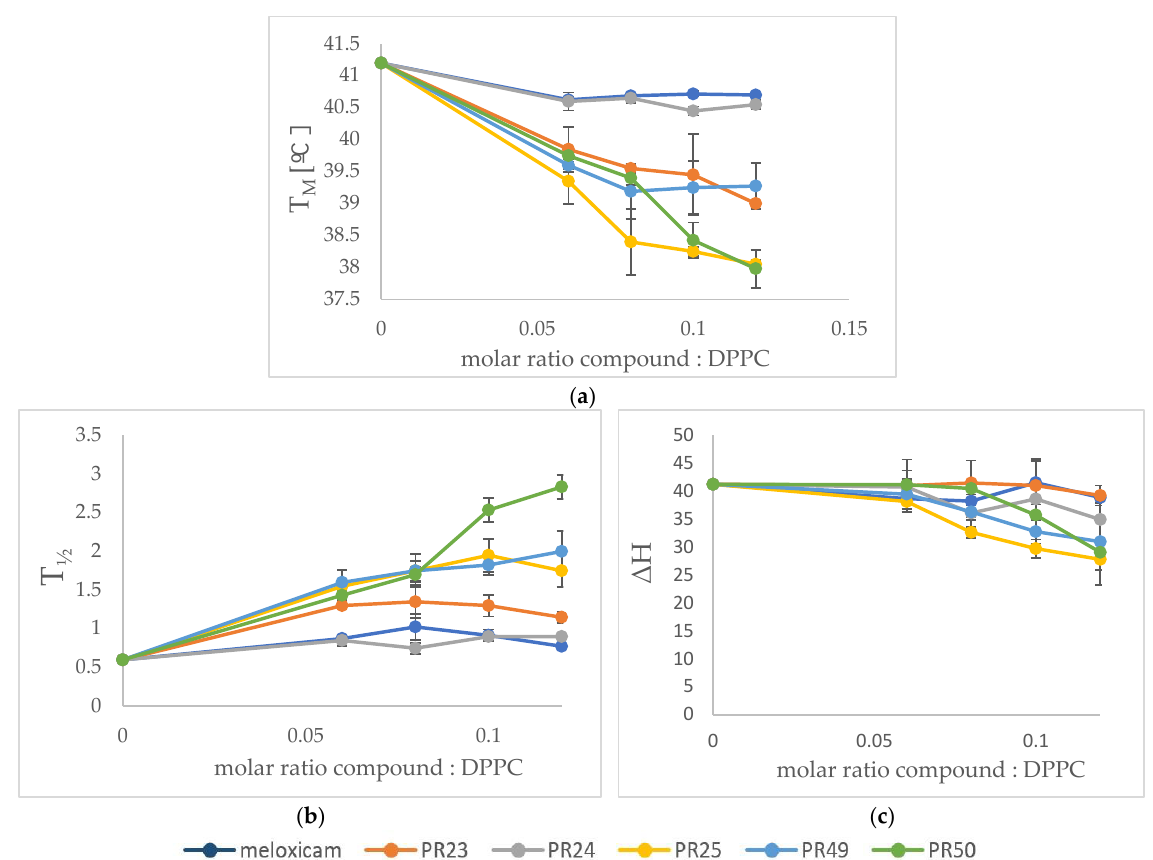
Figure 3. Influence of studied compounds on the parameters of DPPC main phase transition: temperature ( a ), peak width at half-height ( b ), and enthalpy change ( c ). Bars represent standard deviations of four measurements.